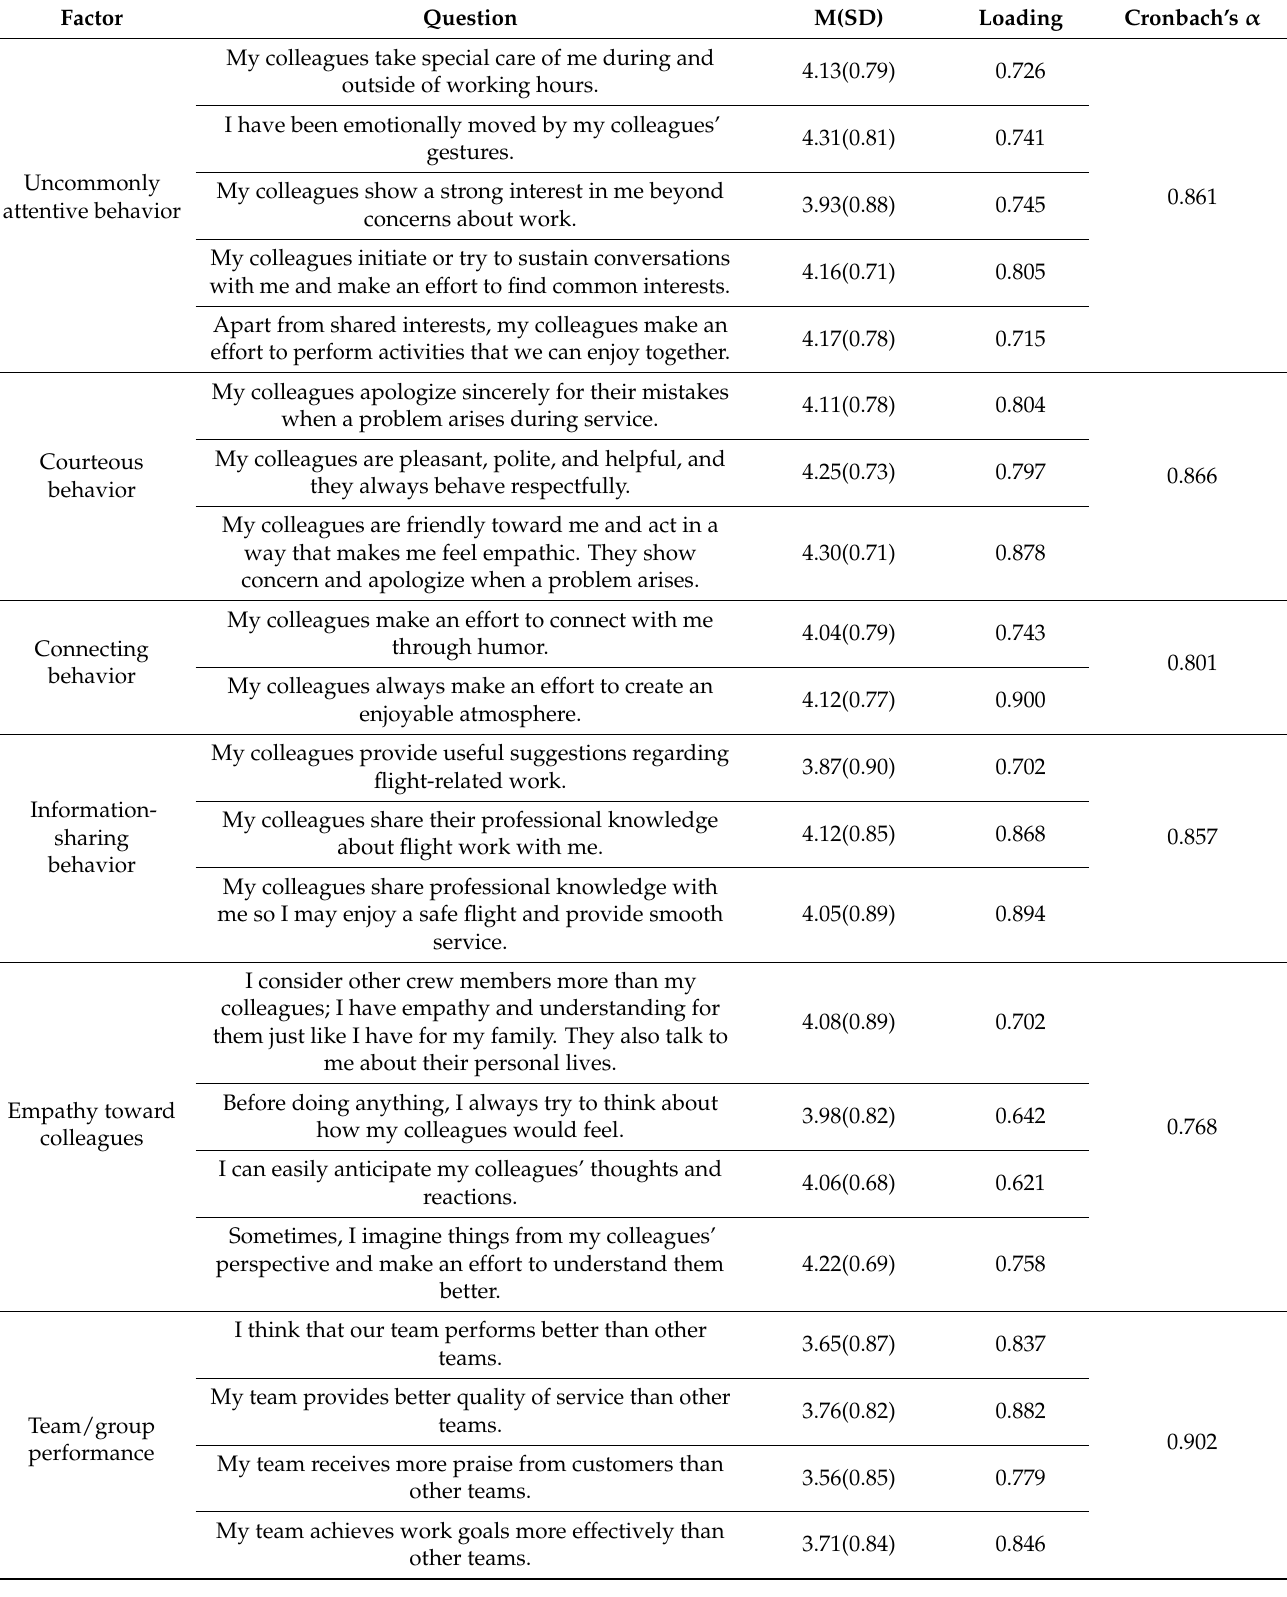
Table 1. Results of CFA and reliability